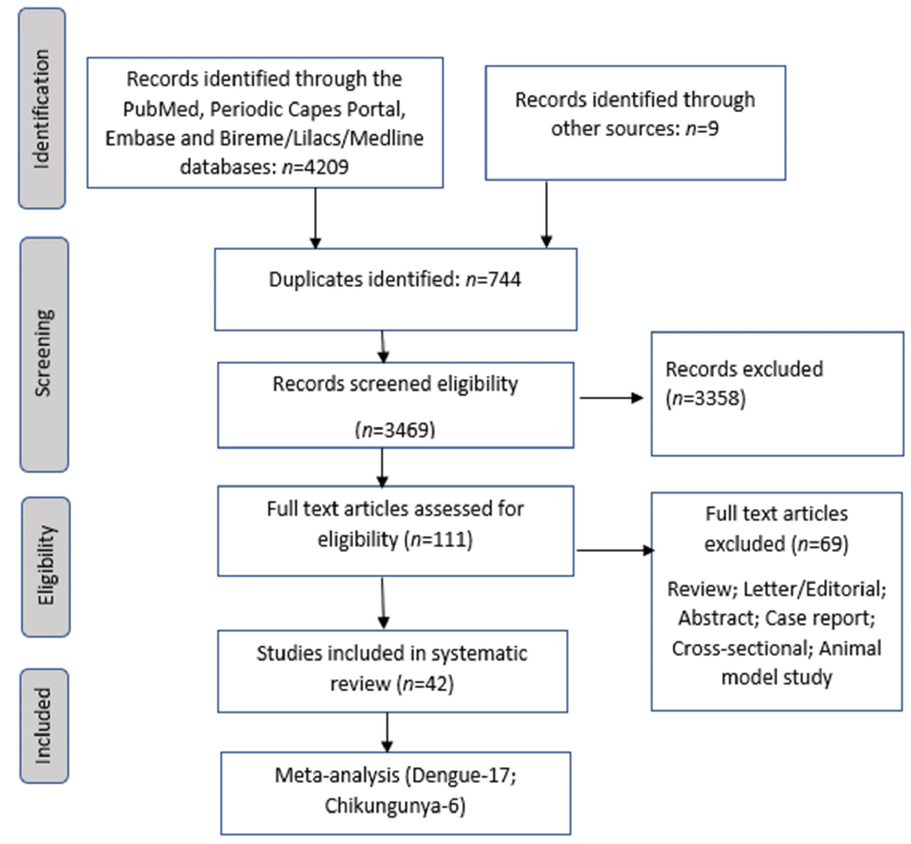
Figure 1. Flowchart of study selection for inclusion in the literature